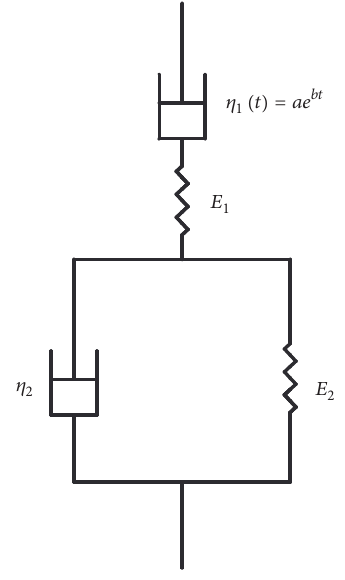
Figure 1: Modified Burgers